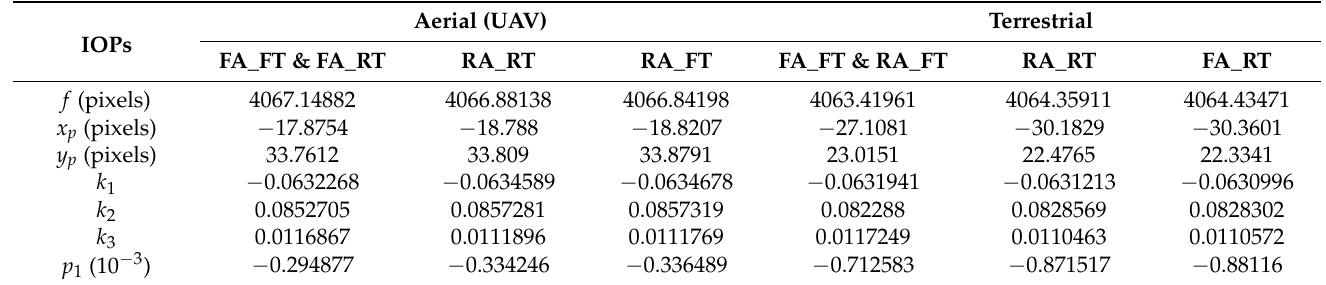
Table 5. IOPs of aerial (UAV) and terrestrial images after the BA of the Pferdestall dataset using different SC strategies.